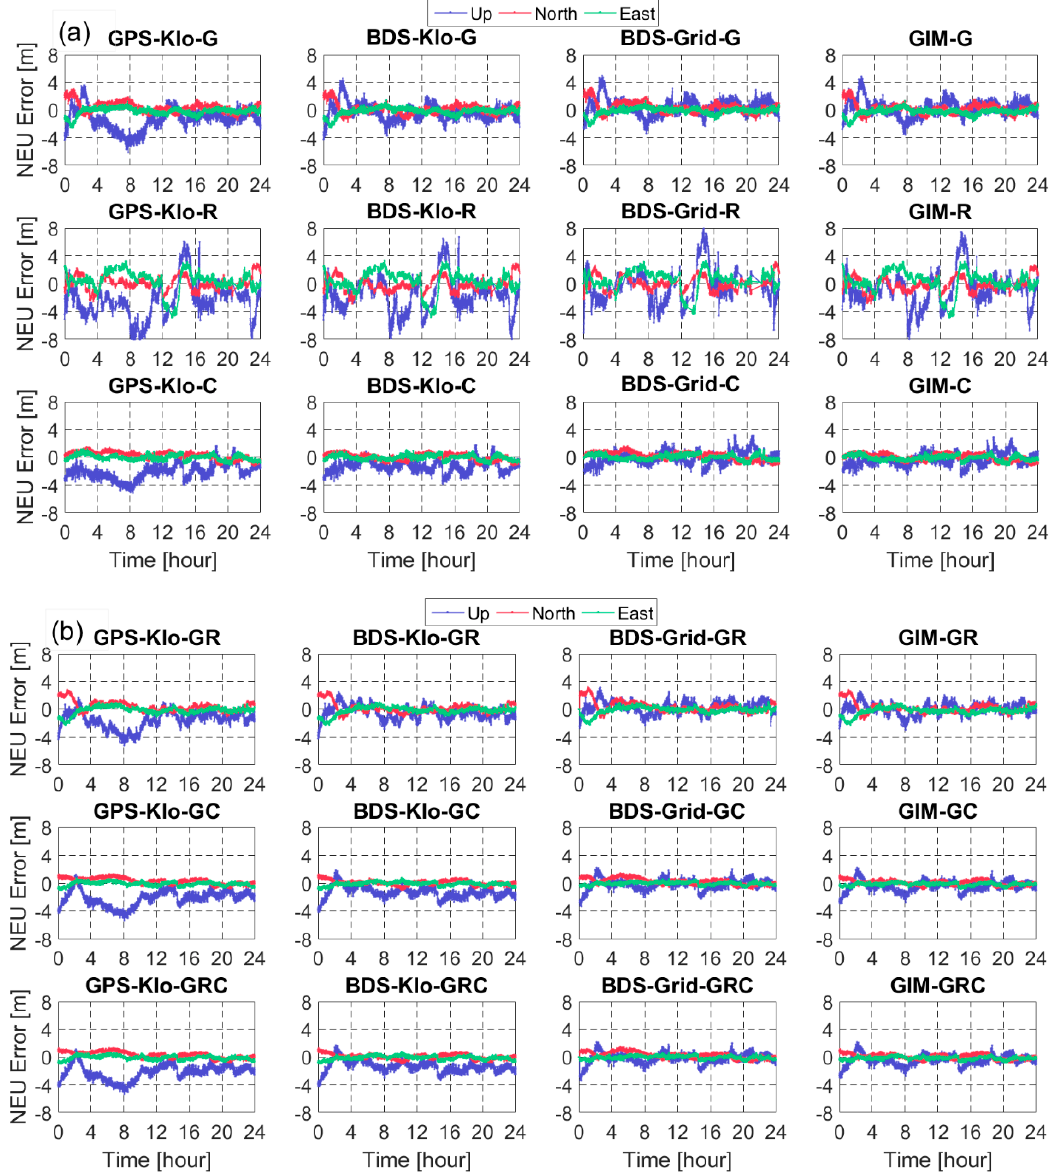
Figure 3. Positioning errors of b1 SF-SPP with different ionospheric models (GPS-Klo, BDS-Klo, BDS-Grid and GIM) in ( a ) single-system or ( b ) multi-system at SNMX station (DoY 36 in 2019, sum of Kp = 0.88, F10.7 = 71 sfu). Where, e.g., GPS-Klo-GRC represents the SF-SPP results using data of GPS + GLONASS + BDS with ionosphere delay corrected using the GPS-Klo model, and the abbreviation G, R and C represent GPS, GLONASS and BDS, respectively.